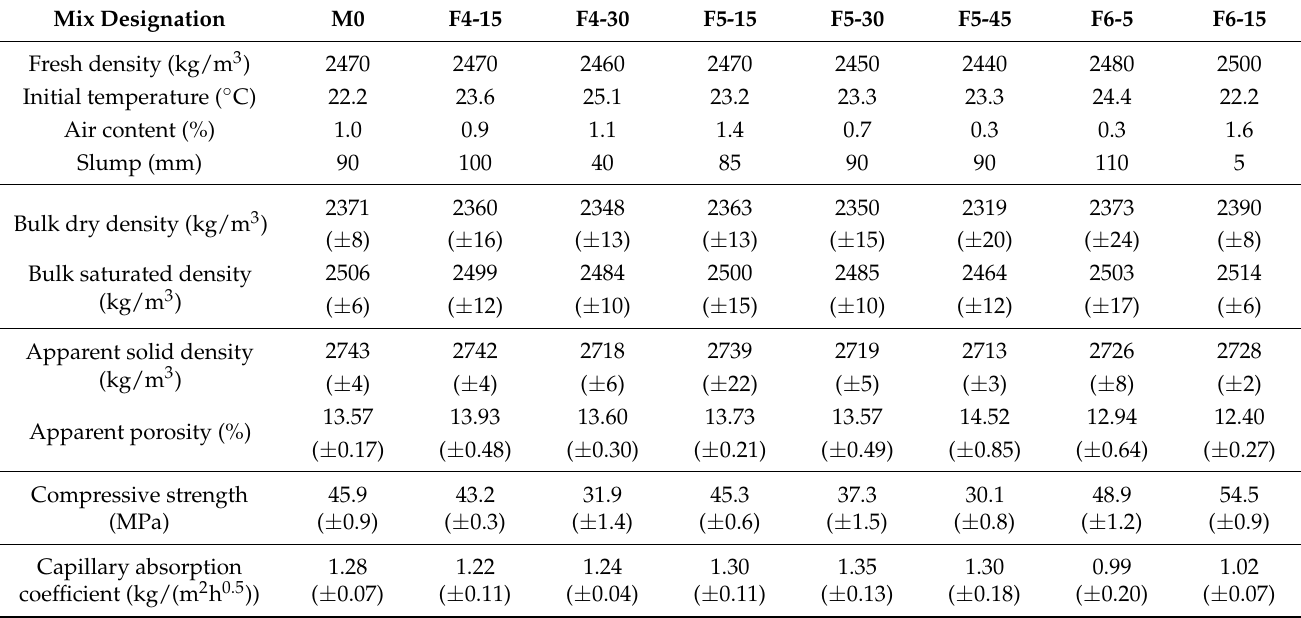
Table 3. Properties of fresh and hardened